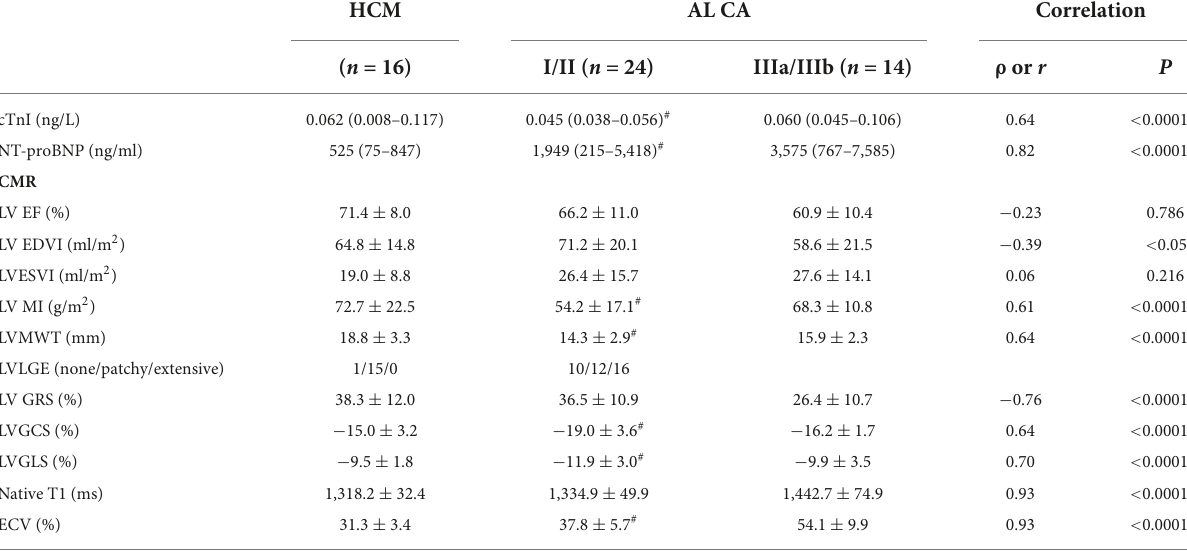
TABLE 2 Clinical and CMR parameters correlation with hypertrophic cardiomyopathy patient and clinical stage in AL amyloidosis patients. HCM AL CA